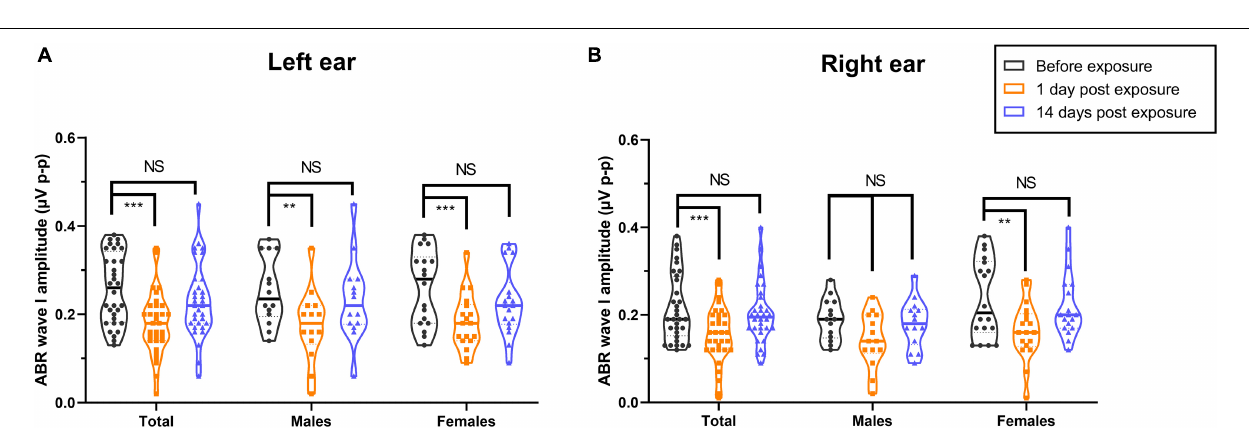
FIGURE 5 | Effects of noise exposure on MHINT. There were no statistically significant differences in the SNRs of MHINT in the overall sample, in males specifically, or in females specifically among baseline (black), 1 day after outdoor music festival noise exposure (orange) and 14 days (blue) after exposure for the left ear (A) or the right ear (B) . Analyses were performed by the two-way repeated measures ANOVA.